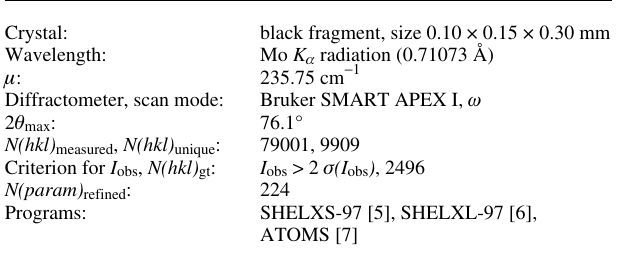
Table 1. Data collection and